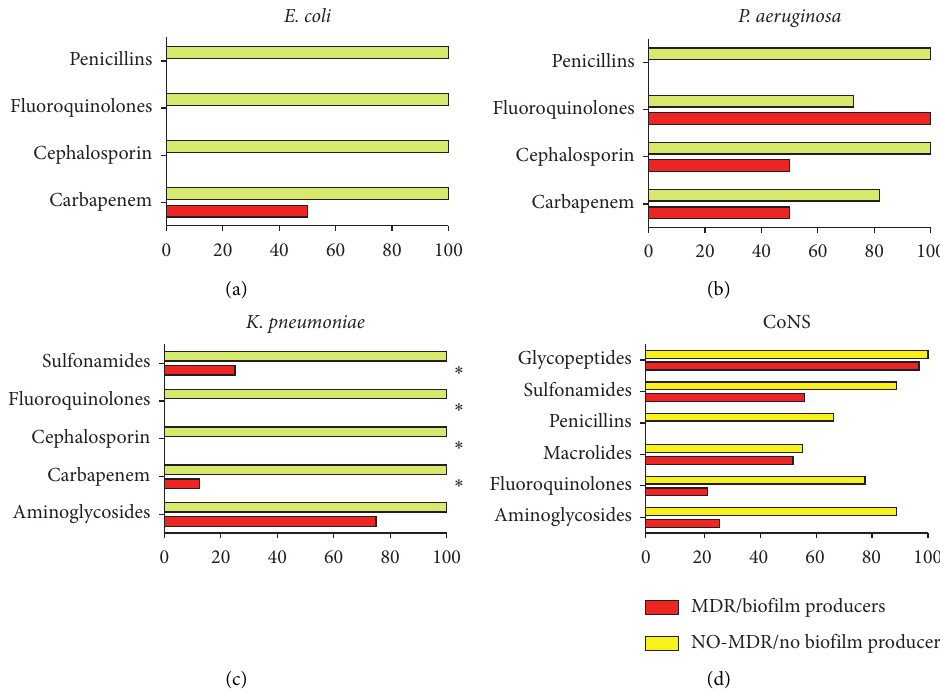
Figure 6: Susceptibility rate to different classes of antibiotics in E. coli (a), P. aeruginosa (b), K. pneumoniae (c), and CoNS (d) between biofilm and non-biofilm producers. ∗ p value <